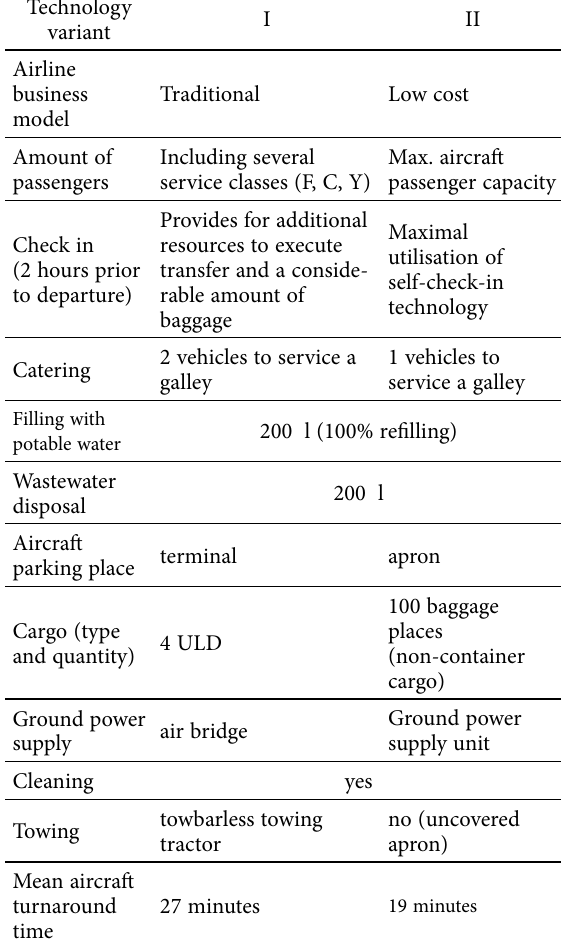
Table 2. Characteristics of ground handling